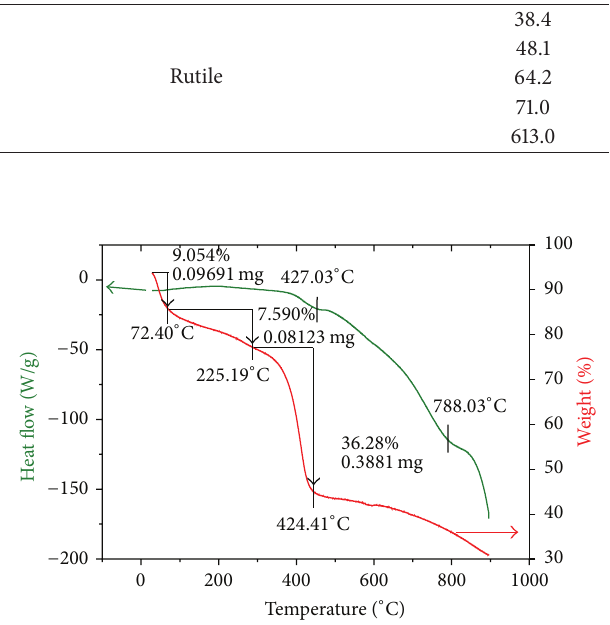
Figure 3: Graph representing TiO 2 nanofibers’ DTA and TGA of solution